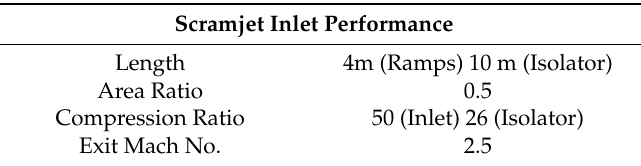
Table 2. Scramjet inlet performance data.